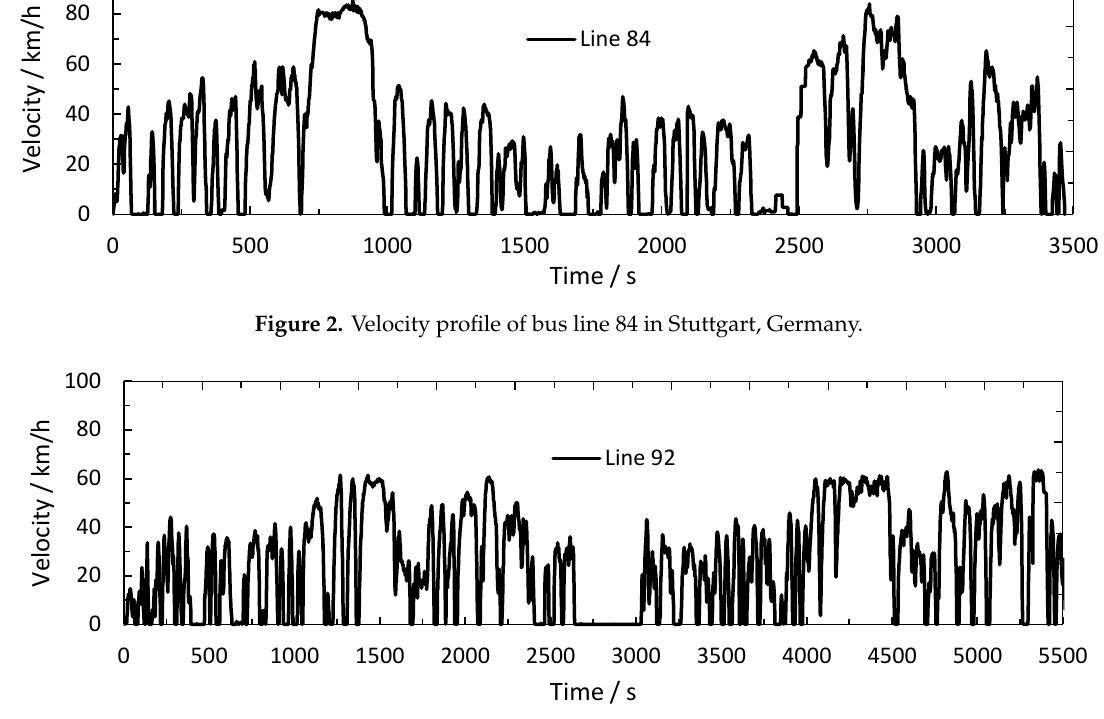
Figure 3. Velocity profile of bus line 92 in Stuttgart, Germany. Table 1. Characteristics of the suburban cycles SORT2 and bus line 84 and the urban bus line 92. The average total speed includes the bus stops.